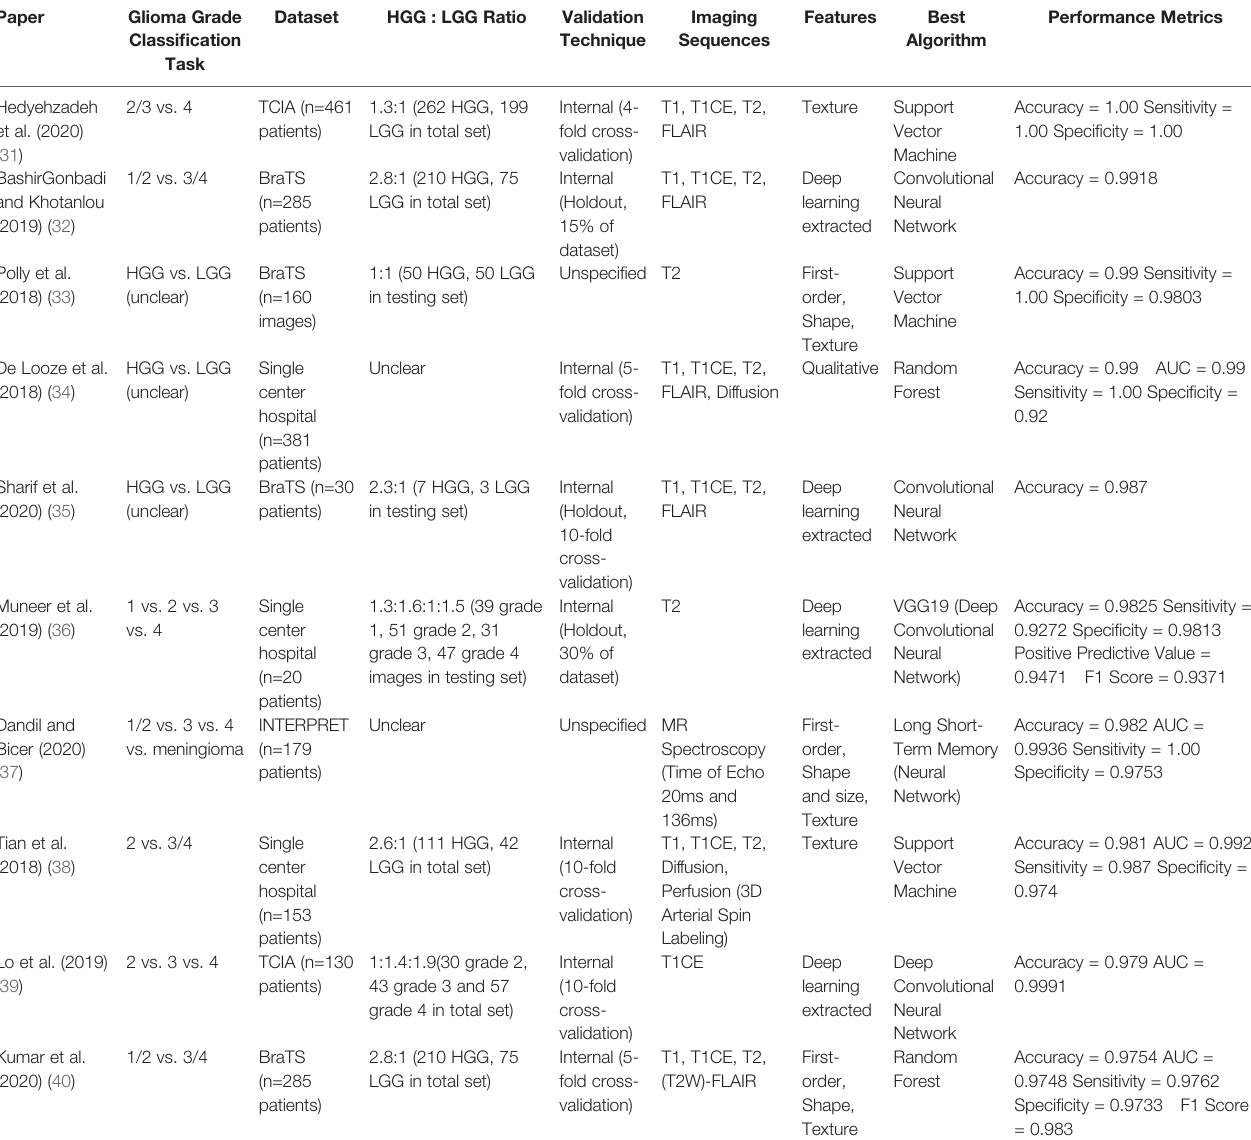
TABLE 2 | Characteristics of the 10 studies reporting the highest accuracy results for their best performing models, including: glioma grade classi fi cation task, dataset source and size, ratio of high- to low-grade gliomas, validation technique, imaging sequences used in prediction, feature types used in prediction, best performing algorithm (based on accuracy results), and performance metrics.